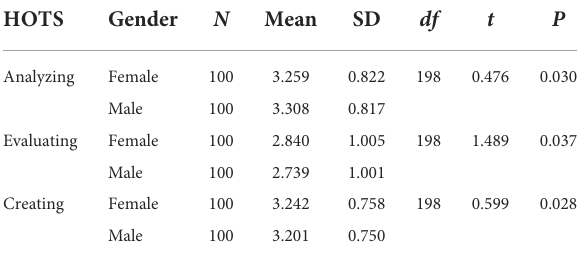
TABLE 5 Gender gap in the learners’ HOTS